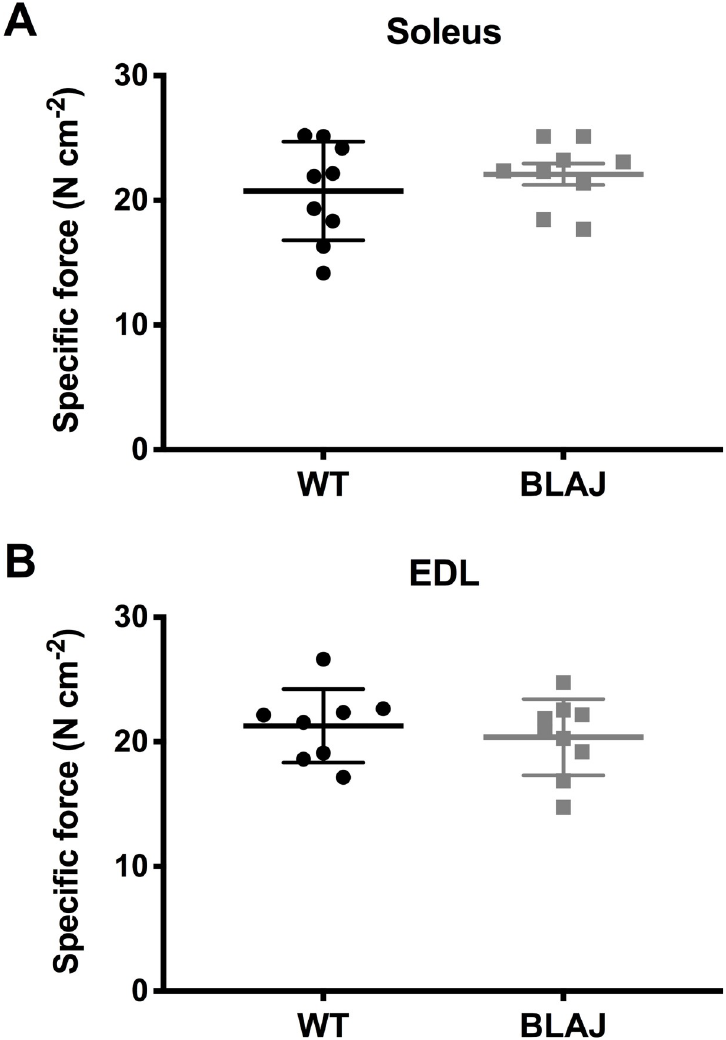
Fig 3. Maximum tetanic force from WT and BLAJ mice aged 10 months. (A) Soleus ( n = 9, 9) and (B) EDL ( n = 8, 9). Data are presented as individual values with horizontal lines indicating mean ± SD.